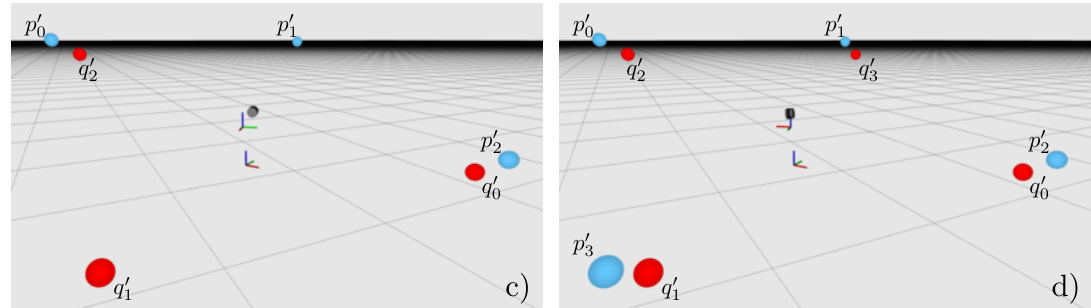
Figure 3. Sphere center points around the revolving LiDAR in the middle of the images. As in Figure 2, the spheres are coloured and denoted with p i , q i , i = 0,1,2,3 according to their respective frustum-direction and the carrier’s i-th orientation R i . From top-left to bottom-right, the sphere centers are estimated by the LiDAR measurements. ( a ) most clearly reveals the fact that two spheres can be seen by the LiDAR without further movement. ( b ) shows the scanner observing the second pair of spheres, after the carrier has turned by 90 ◦ . In the third image ( c ), the first target pair is detected a second time after another 90 ◦ rotation. Note that the different colors indicate that it is seen from a different carrier orientation. Furthermore, note that the center points are not aligned. This results from the actual transformation error between the sensor frame and the platforms base frame. Moreover, it clarifies that a redundant measurement of the surroundings begins after a 180 ◦ carrier rotation. Like ( c ), the last picture ( d ) shows the other redundant sphere detection after the carrier turns further 90 ◦ . In each picture’s center area, the revolving LiDAR is depicted in the coordinate system of the rotating sensor carrier. As can be seen, the LiDAR’s pose with respect to the carrier is static, i.e., it does not change over